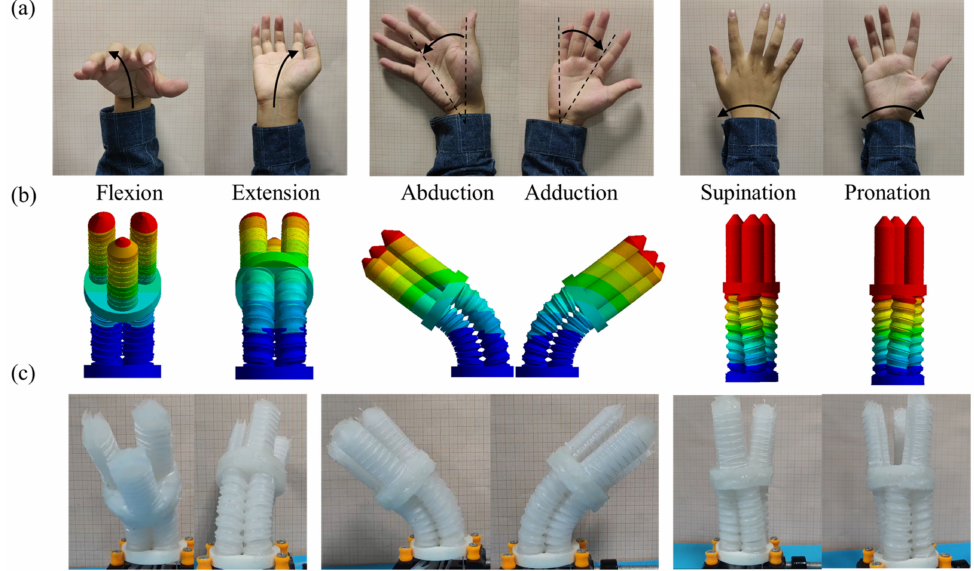
Figure 10. Motion of soft wrist for soft robotic hand: ( a ) real human hand; ( b ) simulation; ( c )